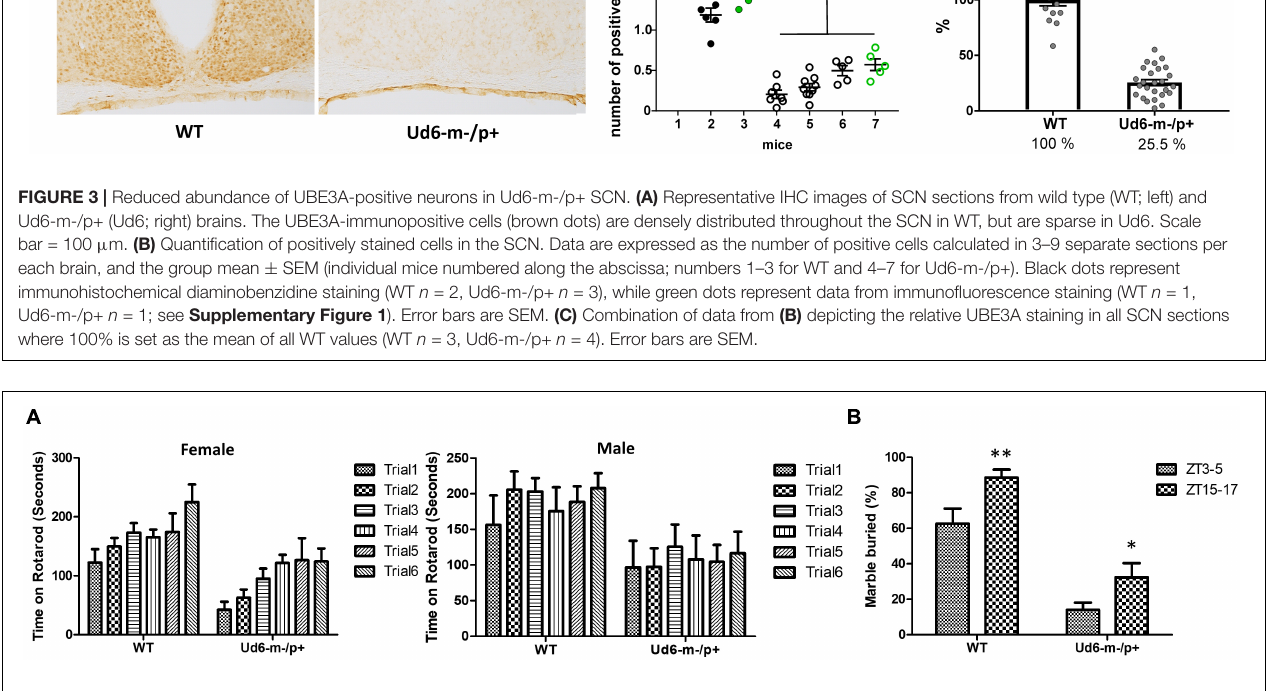
FIGURE 4 | Rotarod and Marble burying behaviors in Ud6-m-/p+ mice. (A) Accelerating rotarod data for Ud6-m-/p+ vs. WT mice, tested over two contiguous days for three trials per day at ZT8-11 under LD conditions. The data are stratified by trials and the sex of mice (Male: 6 WT and 5 Ud6-m-/p+; Female: 8 WT and 11 Ud6-m-/p+) mean ± SEM. Female (8 WT and 11 Ud6-m-/p+): Genotype p < 0.001 and time (2 days) p < 0.05 by two-way repeated ANOVA. Male (6 WT and 5 Ud6-m-/p+): Genotype p < 0.05 and time (2 days) p > 0.5 by two-way repeated ANOVA. (B) Marble burying behavior tested both during the day (ZT3-5) and at night (ZT15-17) under LD conditions (WT: N = 6, Ud6-m-/p+: N = 10) mean ± SEM. p < 0.0001 for both the genotype factor (WT vs. Ud6-m/p+) and the time factor (ZT3-5 vs. ZT15-17) by two-way ANOVA. ∗∗ p < 0.01 for WT and ∗ p < 0.05 for Ud6-m-/p+ assayed at ZT3-5 and ZT15-17 by the Bonferroni